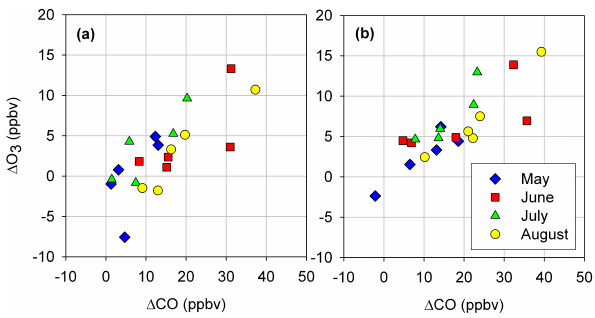
Fig. 10. Scatter plot of 1 O 3 versus 1 CO on a monthly basis for 2002–2006 where 1 O 3 and 1 CO are the differences between the North American averages and the background values defined as the average from (a) Box 8 and (b) the 30th percentile for all data each